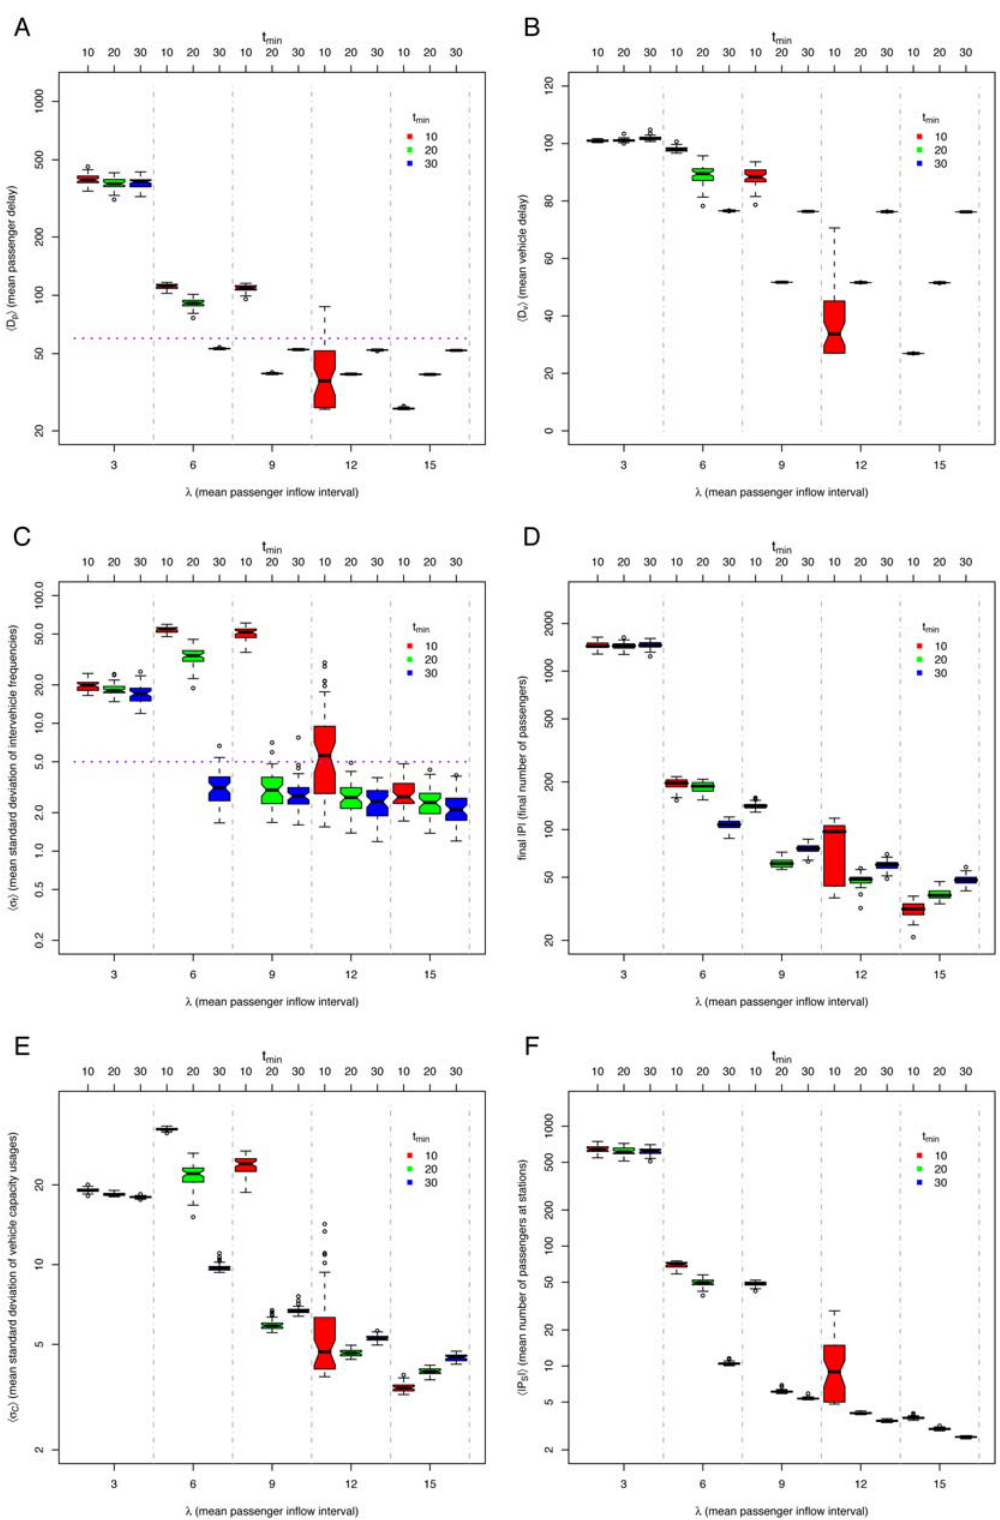
Figure 5. Simulation results for minimum method , varying mean passenger inflow intervals l (lower x axis, separated by vertical dashed lines), different minimum station waiting times t min (upper x axis, also indicated by color of boxes), and number of vehicles V j j ~ 5 : (A) mean passenger delay S D p T (data above horizontal dotted line indicates poor system performance), (B) mean vehicle delay S D v T , (C) mean standard deviation of intervehicle frequencies S s f T (data above horizontal dotted line implies unstable headways), (D) final number of passengers P j j , (E) mean standard deviation of vehicle capacity usage S s C T , and (F) mean number of passengers at stations S P s j j T .